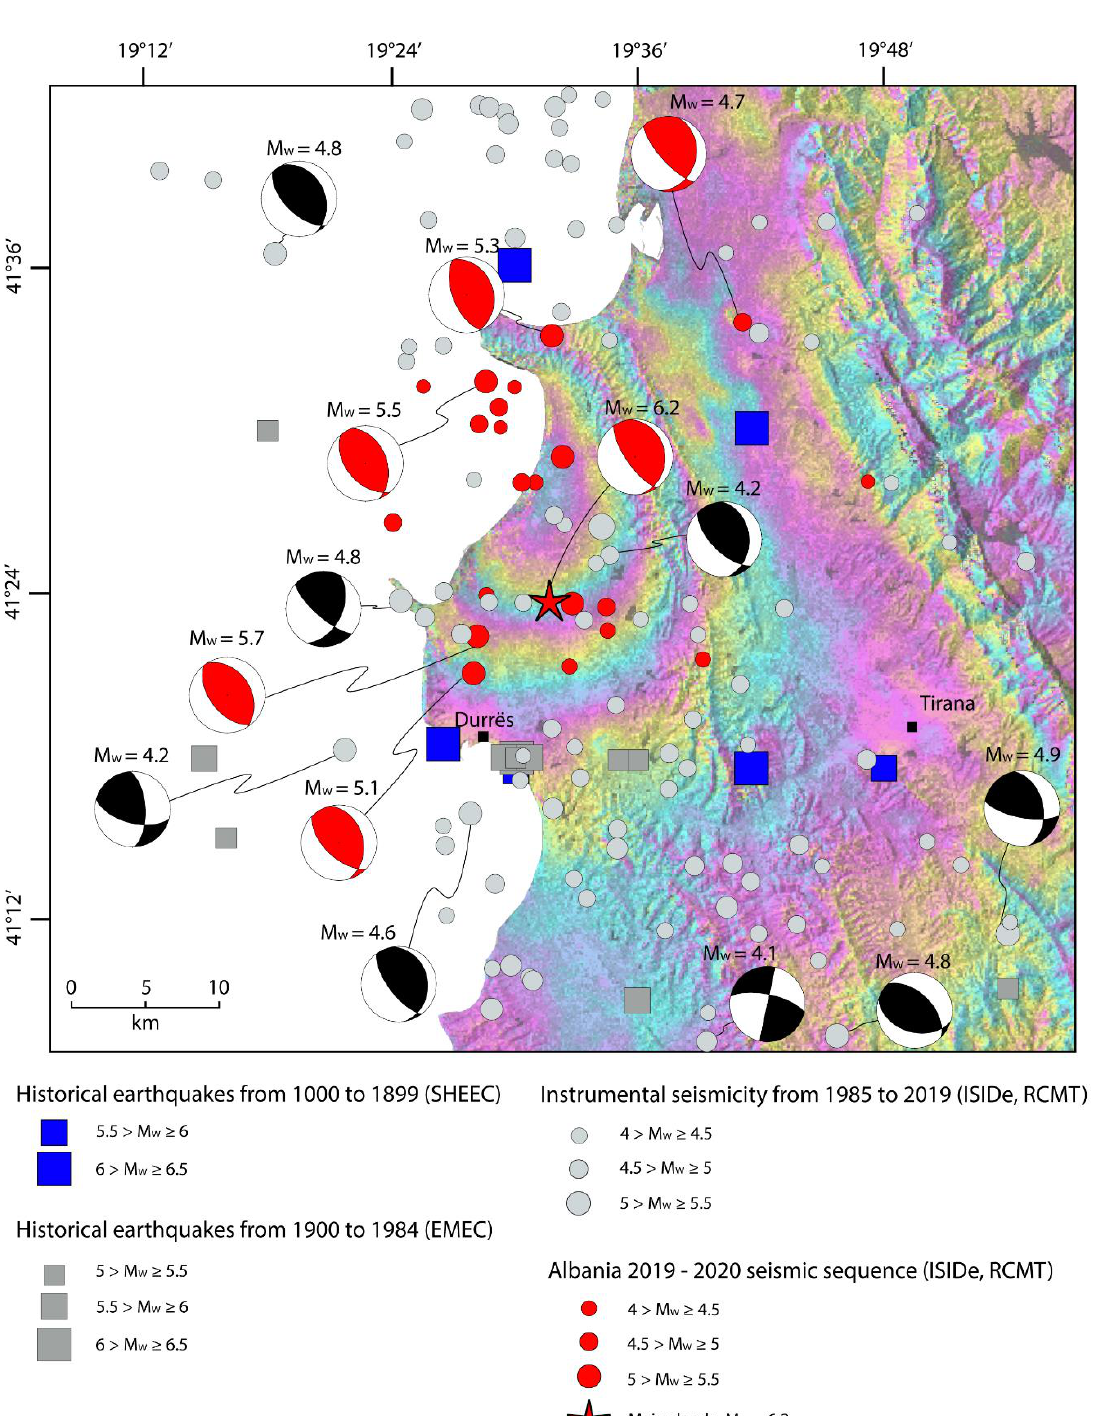
Figure 3. Map showing epicenter location and focal mechanisms for the 2019–2020 seismic sequence (red circle) and seismic events selected by INGV for the period 1985–2019 (grey circle). The epicenters are plotted using the location from the ISIDe [26], while magnitude (M W ) and focal mechanism data are from the RCMT catalogue [25,29]. Historical earthquakes from 1000 to 1899 (blue squares) are selected by SHEEC catalogue [23,30] and from 1900 to 1984 by GFZ [22,31]. The co-seismic interferogram from Sentinel 1 [32] is shown as an overlay draped onto the digital elevation model [33].